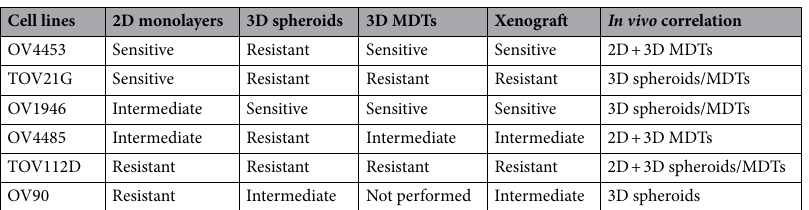
Figure 2. In vivo response of EOC xenografts to carboplatin treatment. (A) Timeline for weekly in vivo chemotherapy cycle in our xenograft mouse model. Carboplatin was delivered intraperitoneally (IP). ( B ) Volume measurements of xenograft tumors (N = 8 per condition) throughout carboplatin treatment. ( C ) IF quantification of Ki-67 stain (normalized to control). Sensitive cell lines are indicated in green fonts, intermediate in blue and resistant in red. Data are the mean ± SEM. ns = non-significant. * p < 0.05, ** p < 0.01, *** p < 0.001, **** p < 0.0001. Cell